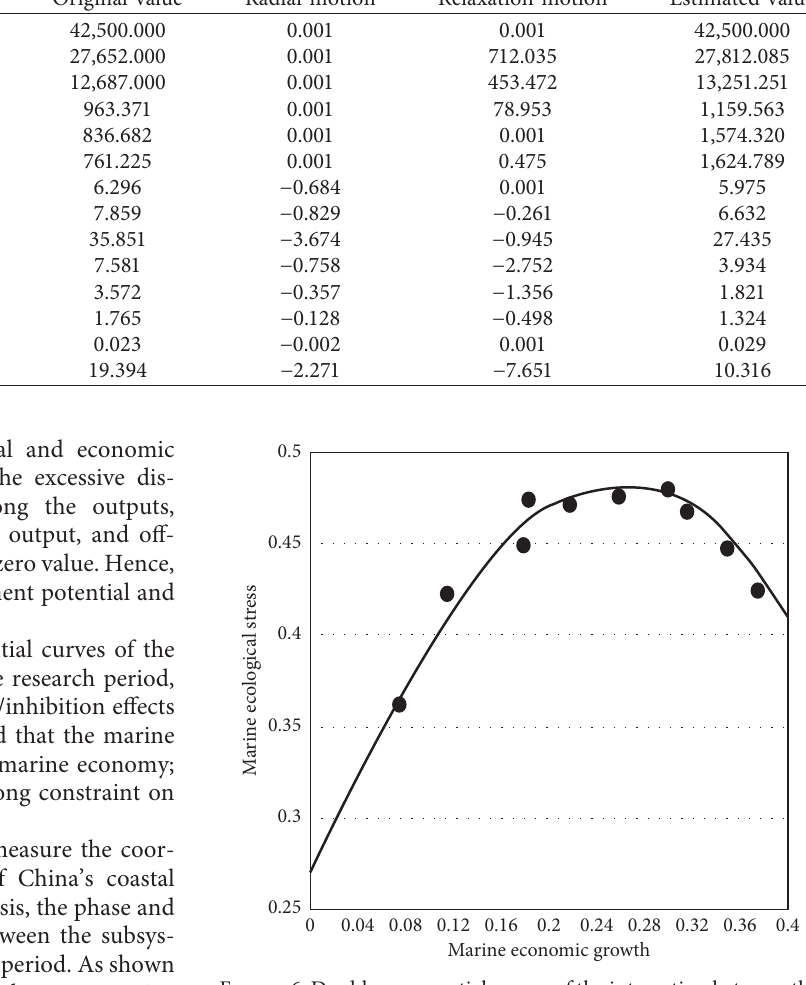
Figure 6: Double exponential curves of the interaction between the